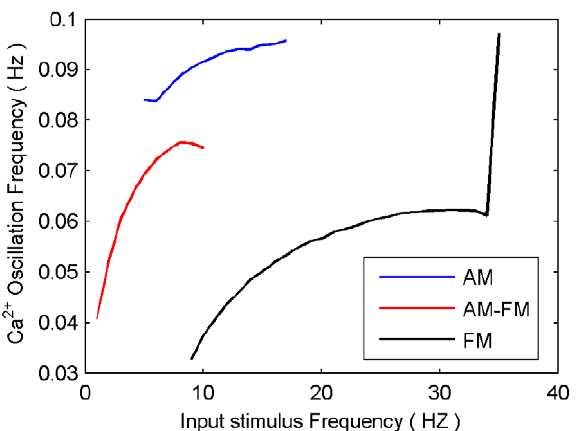
Figure 5. Supervised learning at S2. Network consists of pre- synaptic neurons N1 and N3, post-synaptic neurons N2 and N4 and the interconnecting astrocyte. S1 communicates bi-directionally by releas- ing neurotransmitter (NT) and receiving gliotransmitter (GT) while S2 only receives GT from the astrocyte.